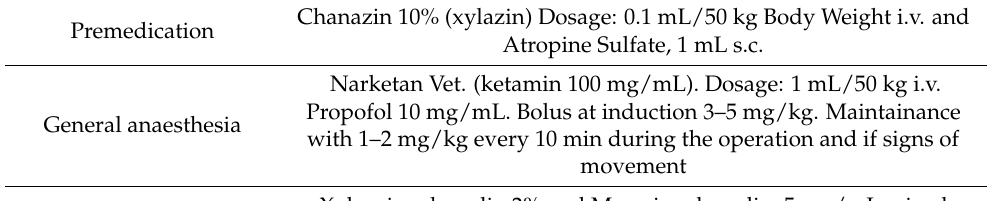
Table 1. Medication and